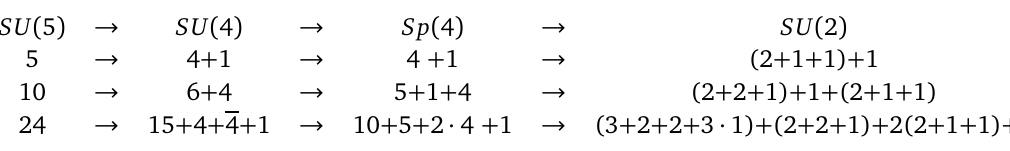
Table 4: Embedding of representations of various subgroups into representations of SU ( 5 ) .